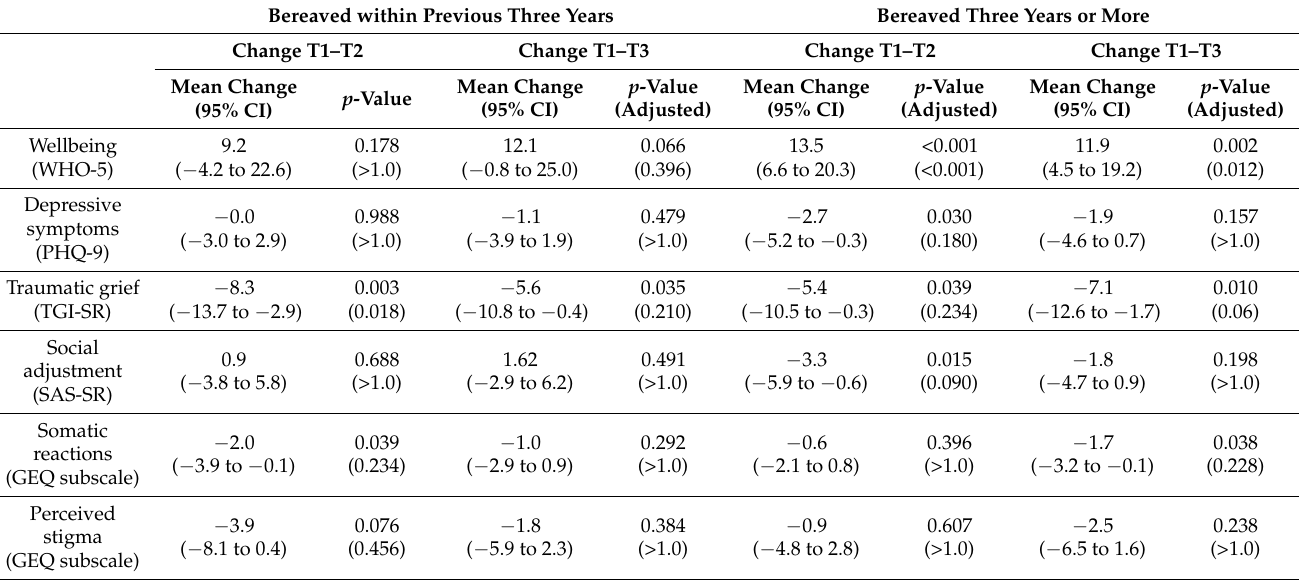
Table 4. Change in outcome measures at three-month (T2) and six-month (T3) follow-up according to time since